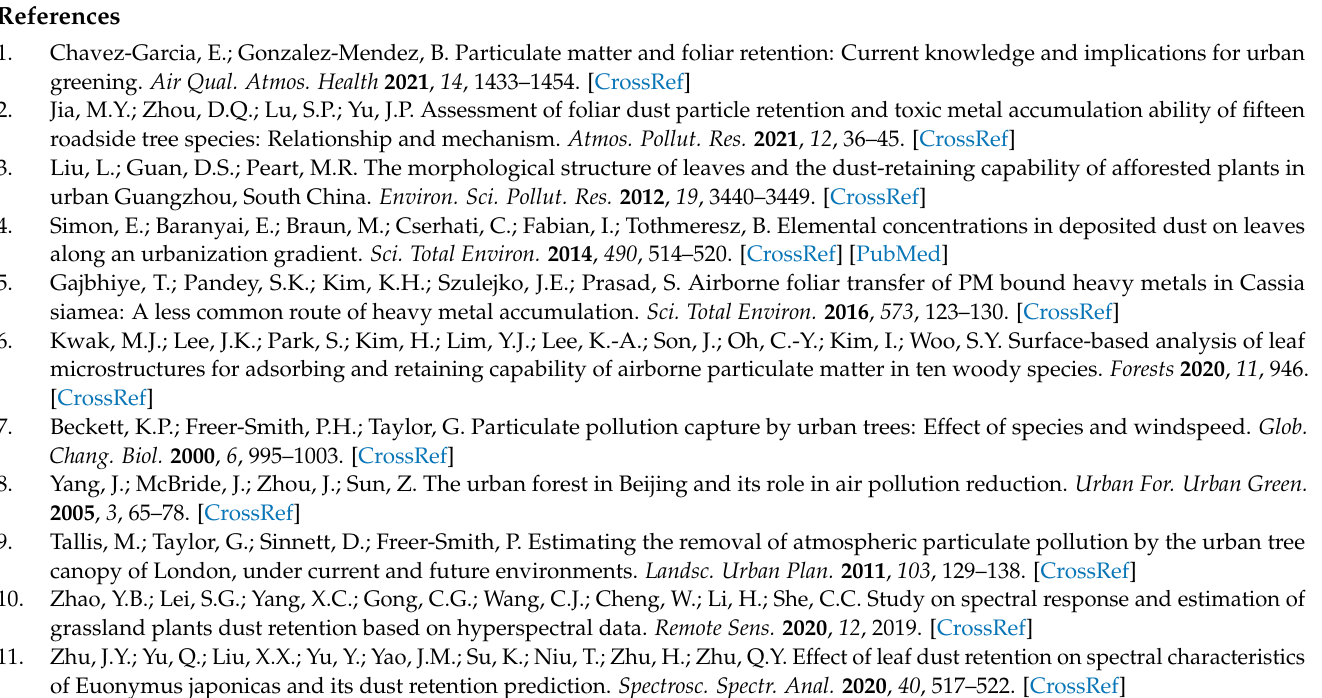
camera. Table S2. Detailed information of all stations’ data and fitting lines. Latitude and longitude are detected in the WGS84 coordinate system; plants are all evergreen. Figure S1. Fitting curves of 14 stations between their atmospheric PM10 concentrations and the normalized difference vegetation index ( δ NDVI). They were separated from Figure